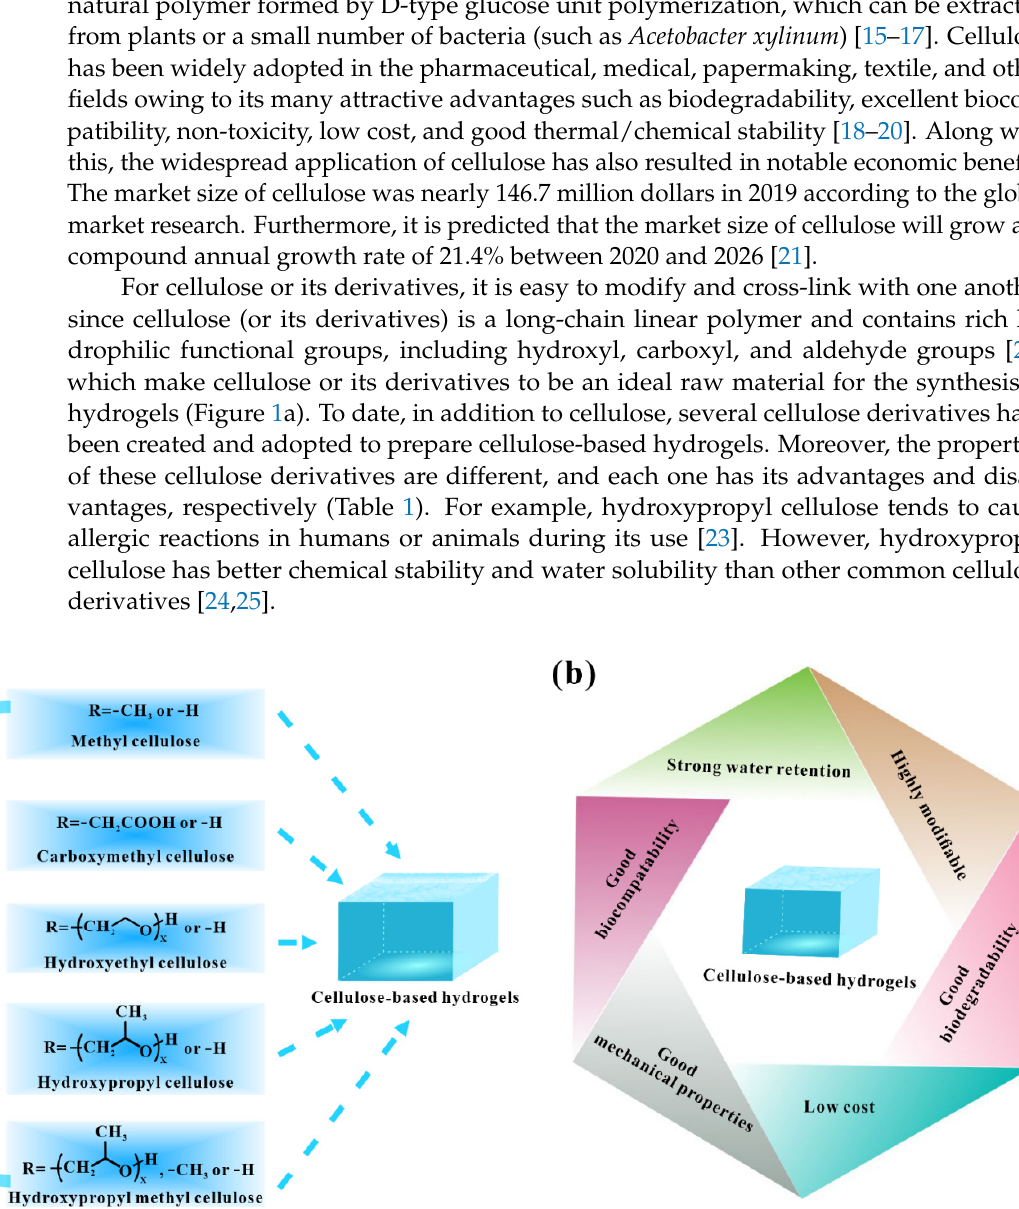
Figure 1. Representative cellulose derivatives for synthesis of cellulose-based hydrogels ( a ) and advantages of cellulose-based hydrogels in practical applications ( b ).